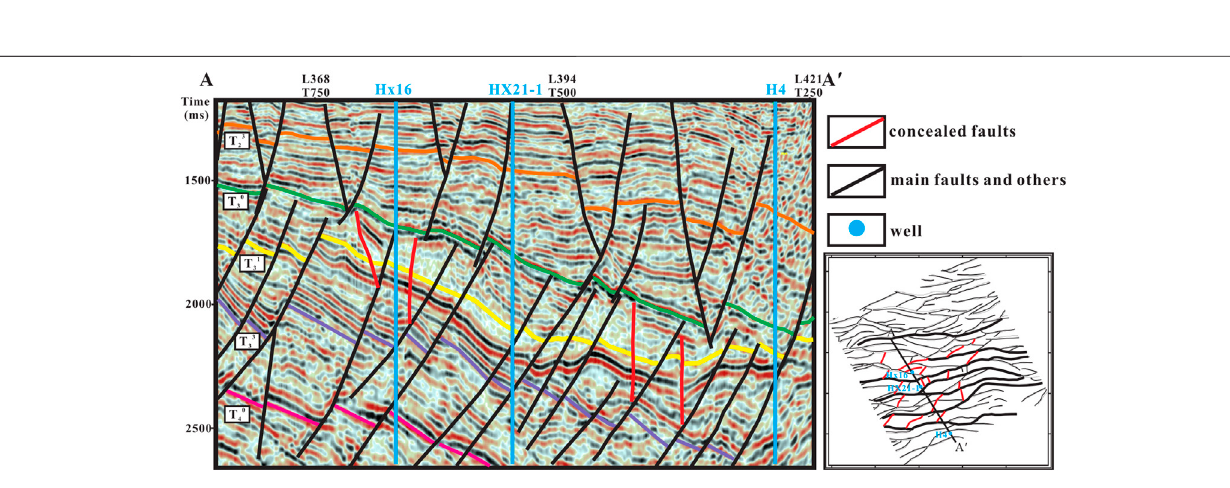
Frontiers in Earth Science |